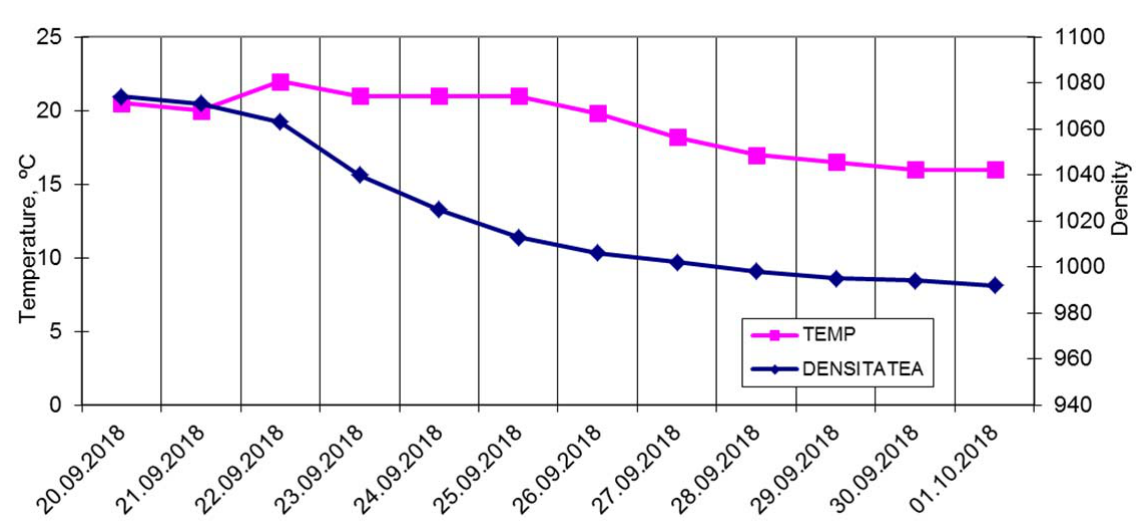
Figure 4. Dynamics of the process of alcoholic fermentation of Rara Neagr ă grape mush in microwinery conditions ( harvest year